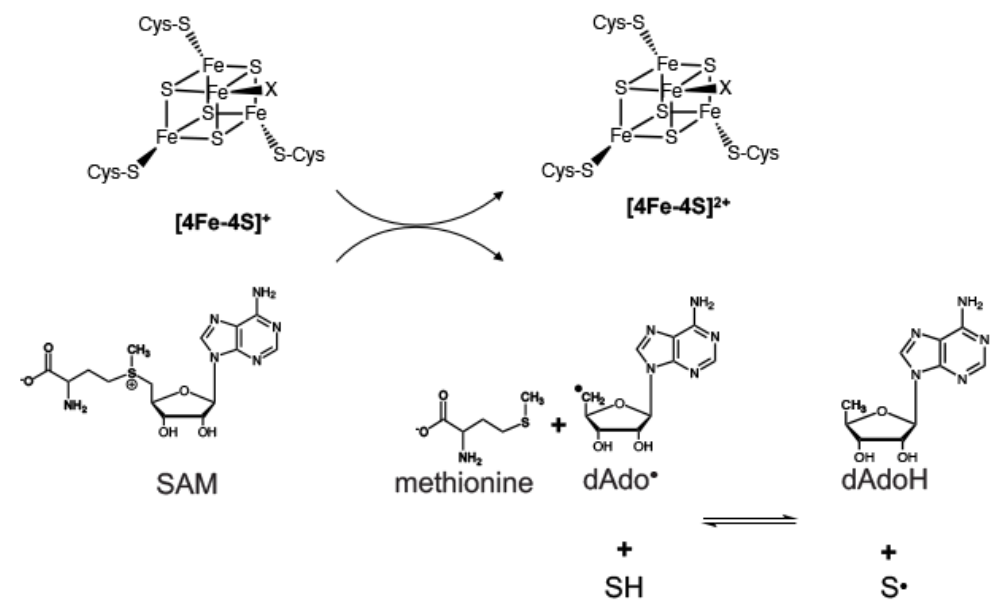
Figure 6. A general scheme for the mechanism of radical-SAM enzymes. The [4Fe-4S] that is bound to the conserved C-X 3 -C-X 2 -C motif provides the electron required for the reductive cleavage of SAM. In this reaction, methionine and the adenosyl radical (dAdo · ) is generated. The formed dAdo · then abstracts a hydrogen atom from the substrate (SH), and a substrate radical (S · ) and dAdoH are